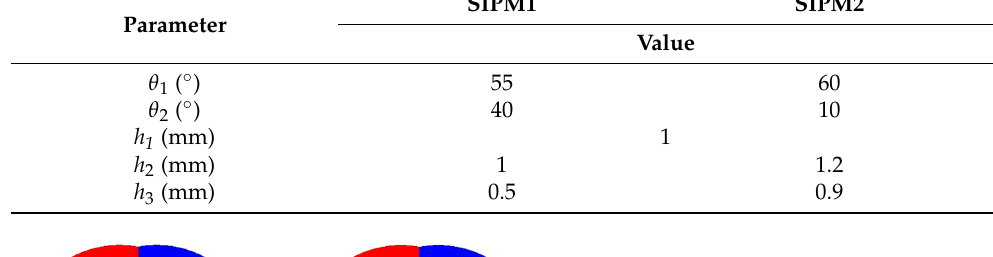
Table 3. Optimization results of key parameters for SIPM.